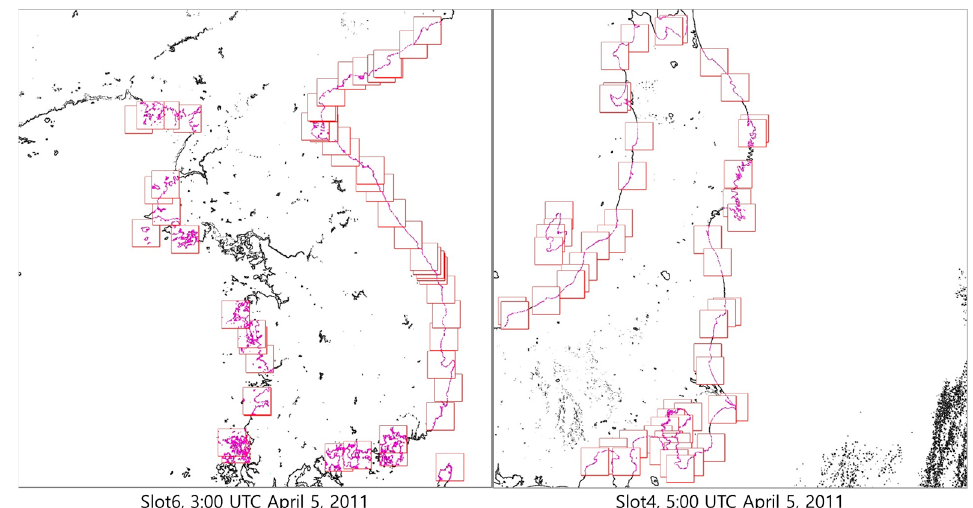
Figure 13. Shoreline-matching–result images (after RANSAC).